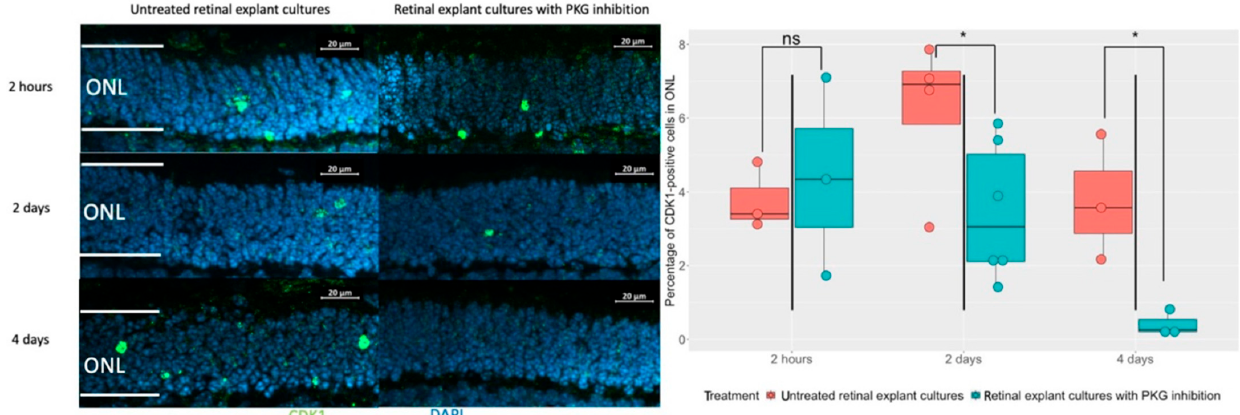
Figure 2. Evaluation of the relation between the cGMP-PKG system and CDK1. Retinal explants from the rd1 strain were treated with 50 µM Rp-8-Br-PET-cGMPS (PKG inhibitor) for either 2 h, 2 days, or 4 days towards the end of the culturing, and complemented with their untreated counterparts. Left panel shows immunostaining of CDK1 (green) within the ONL in rd1 retinal explants with different lengths of PKG inhibition, as well as their untreated peers. DAPI (blue) was used as nuclear counterstain. The box chart shows the comparison of CDK1 + photoreceptors between retinal explants treated with PKG inhibitor and controls at different lengths of treatment (n = 3–6). * p < 0.05. ONL = Outer nuclear layer.